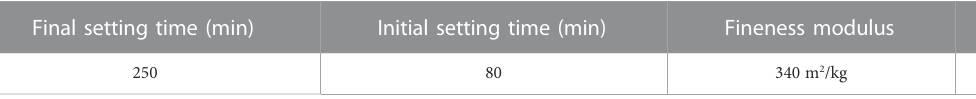
TABLE 1 Properties of the cement used.